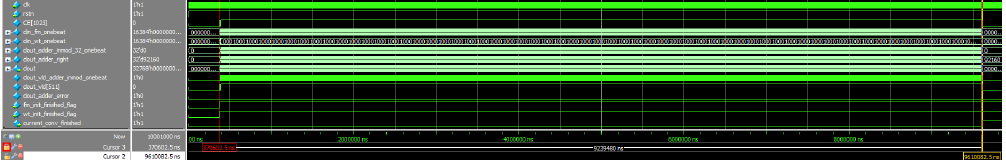
Figure 16. The simulation waveforms of 128 × 64 × 3 × 3.